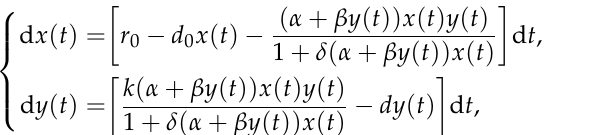
Table 1. Biological significance of each parameter. Parameters Biological Significance r 0 The birth rate of prey. d 0 The natural death rate of prey. d The natural death rate of predator. α The attack rate per predator to prey. δ The predator’s handing time of prey. k Conversion efficiency. β Parameter of predator in hunting